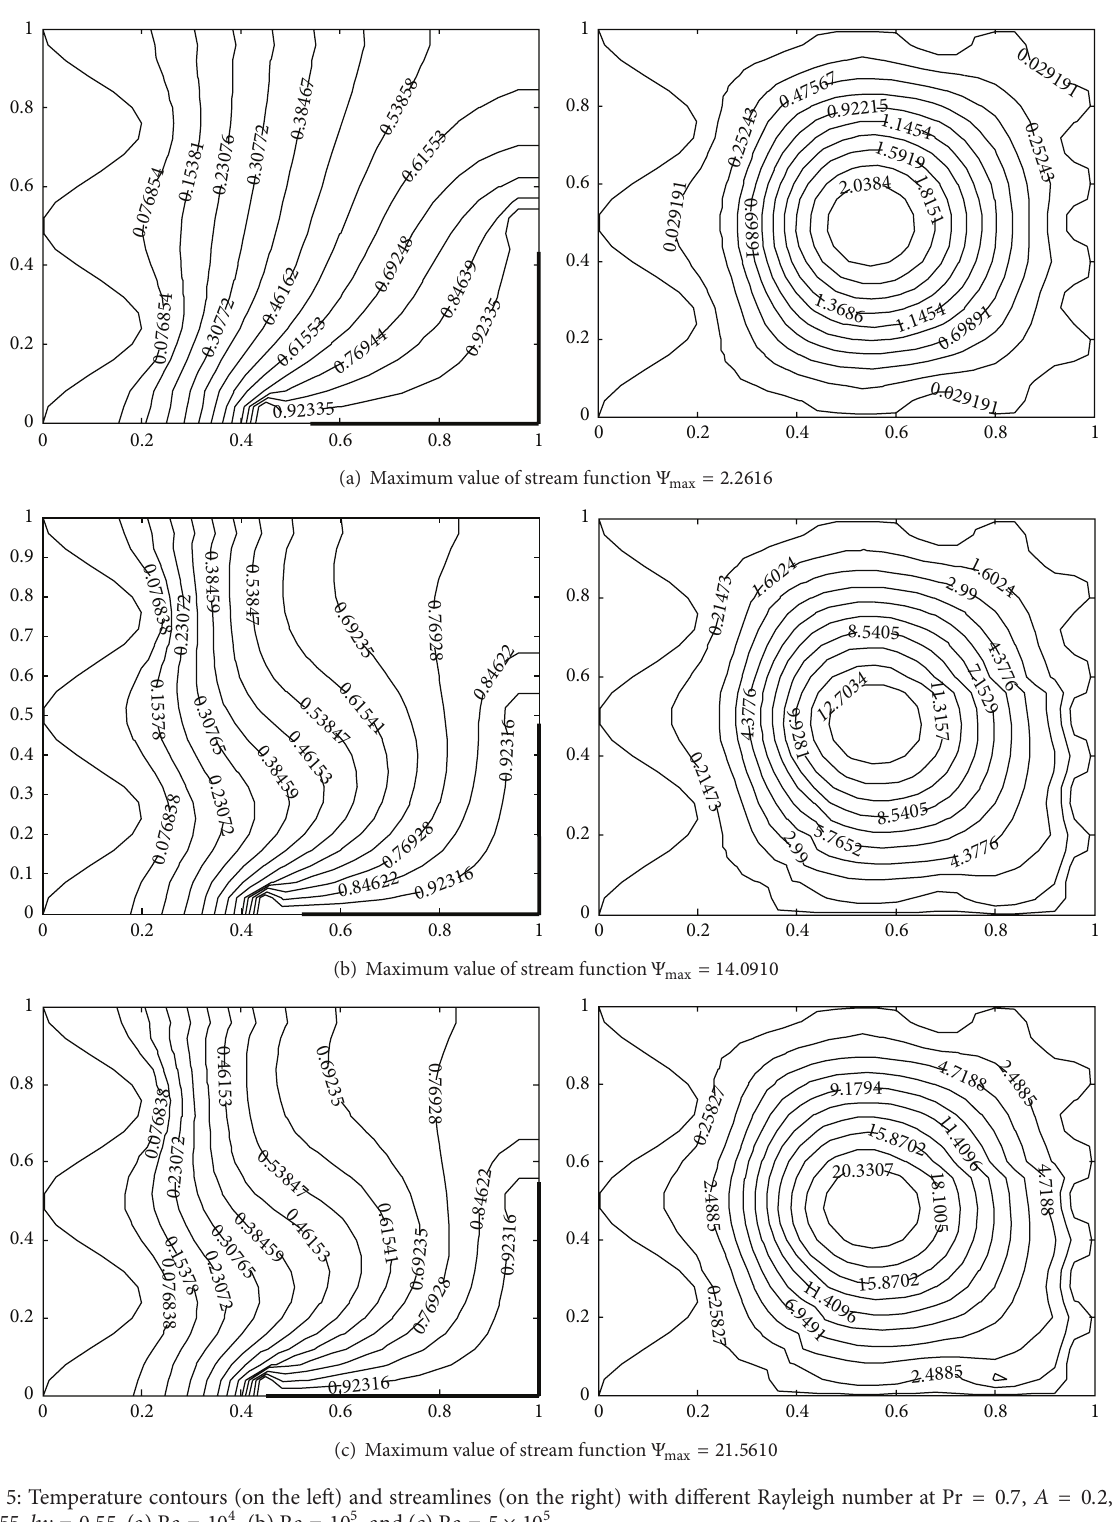
Figure 5: Temperature contours (on the left) and streamlines (on the right) with different Rayleigh number at Pr = 0.7 , 𝐴 = 0.2 , 𝑛 = 2 , ℎ𝑥 = 0.55 , ℎ𝑦 = 0.55 , (a) Ra = 10 4 , (b) Ra = 10 5 , and (c) Ra = 5 × 10 5